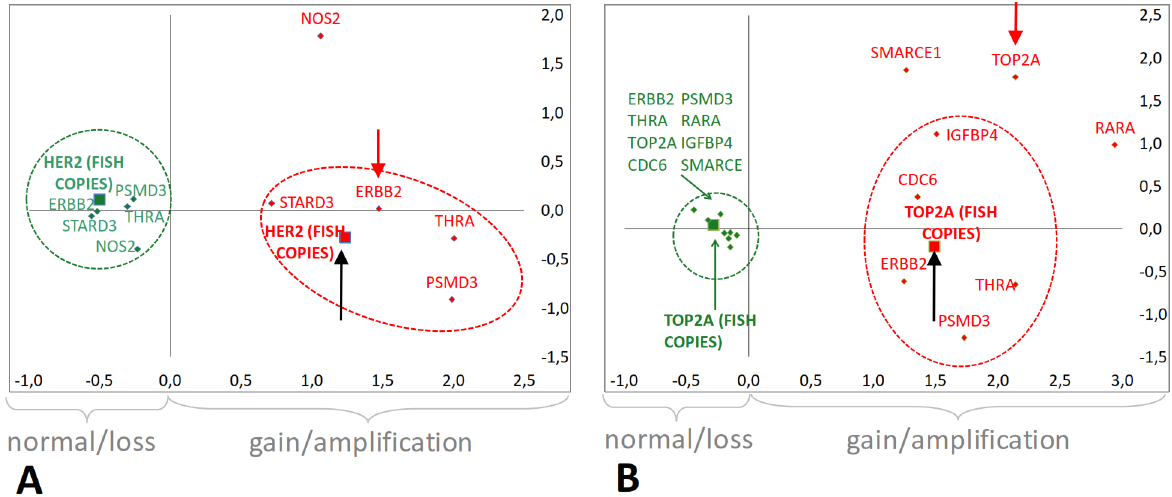
Figure 3. Multiple Correspondence Analyses graphs for comparing gene copies as assessed with qPCR and FISH. A: Correspondence of HER2 FISH (copies) to CN variables (n=398). B: Correspondence of TOP2A FISH (copies) with CN variables co-expression (n=393). Green: normal or loss; red: gain or amplification.